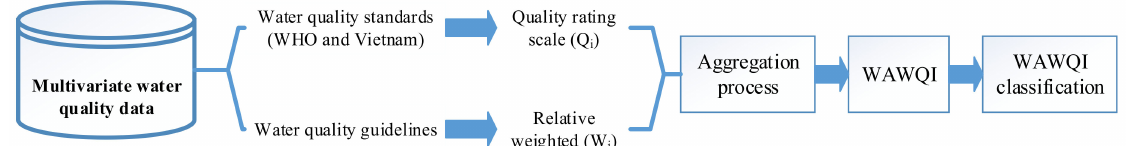
Figure 4. Flowchart of the weighted arithmetic water quality index (WAWQI)